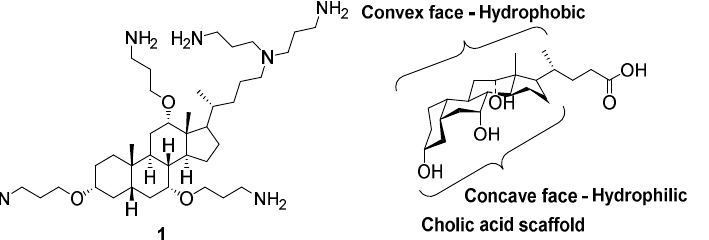
Figure 2. Structure of the synthetic SMAMP 1 and the facial amphiphilicity of the cholic-acid scaffold.